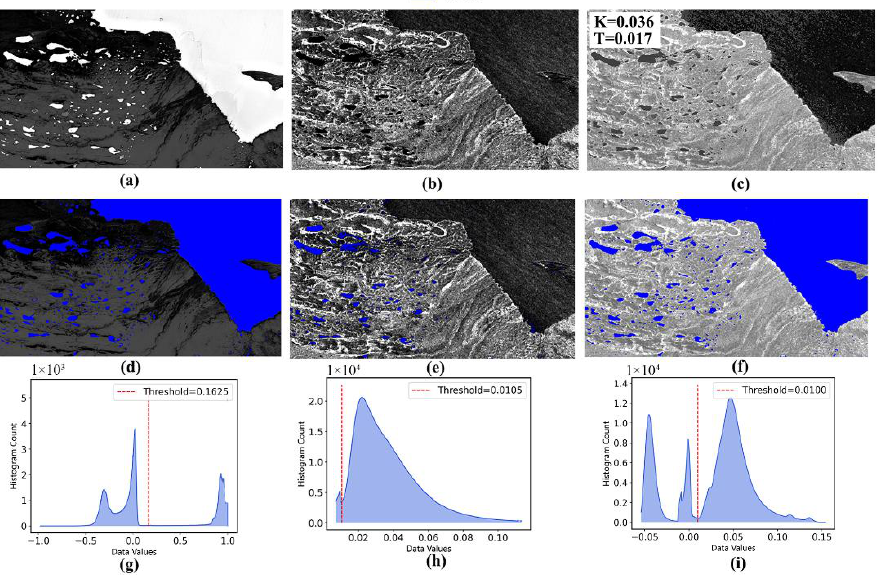
Figure 10. Waterbody extraction map for the Ulan-Ula Lake area under strong wind: ( a ) NDWI. ( b ) HH. ( c ) SOWI. ( d ) Water extraction based on the NDWI. ( e ) Water extraction based on VV. ( f ) Water extraction based on the SOWI. ( g ) NDWI histogram. ( h ) VV histogram. ( i ) SOWI histogram. The red lines in ( g , h , i ) represents the threshold.